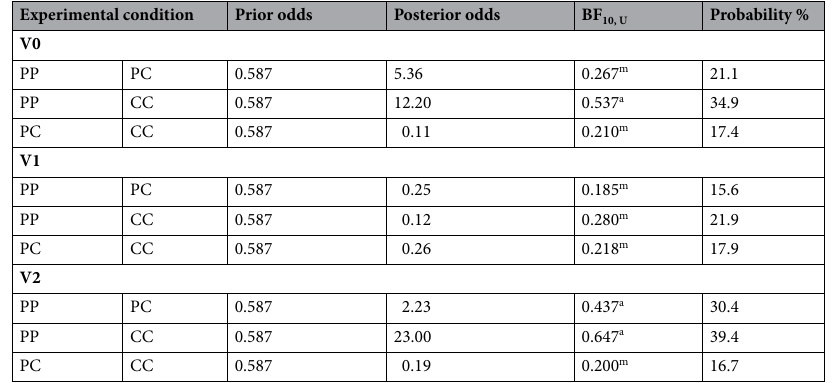
Table 2. Bayesian analysis for the comparison of symbolic analysis parameters obtained at supine position and at different caffeine supplementation conditions. The posterior odds have been corrected for multiple testing by fixing to 0.5 the prior probability that the null hypothesis holds across all comparisons (Westfall, Johnson, & Utts, 1997). Individual comparisons are based on the default t test with a Cauchy (0, r = 1/sqrt(2)) prior. The “U” in the Bayes factor denotes that it is uncorrected (PP: Placebo–Placebo; PC: Placebo–Caffeine; CC: Caffeine–Caffeine). Letters indicate the outcome classified as: A = anecdotal; M = moderate; V = very strong; E = extreme favoring the alternative hypothesis; a = anecdotal; m = moderate favoring the null hypothesis.